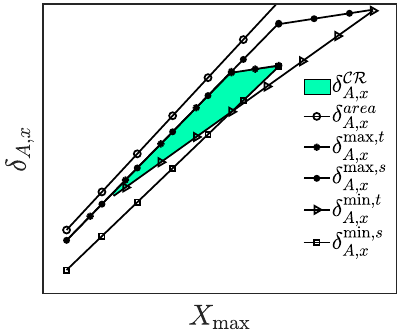
Figure 11. Linearised bounds on δ A , x . Table 3. Range of parameters for which the approximations (21) and (22) are valid.